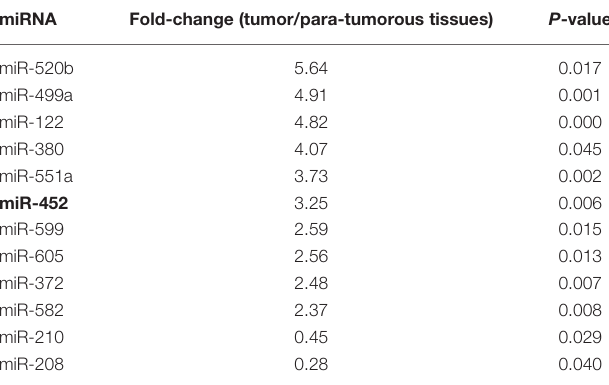
TABLE 3 | Differentially expressed miRNAs in tumor and tumorous tissues (fold-change > 2.0 and P < 0.01). miRNA Fold-change (tumor/para-tumorous tissues) P -value